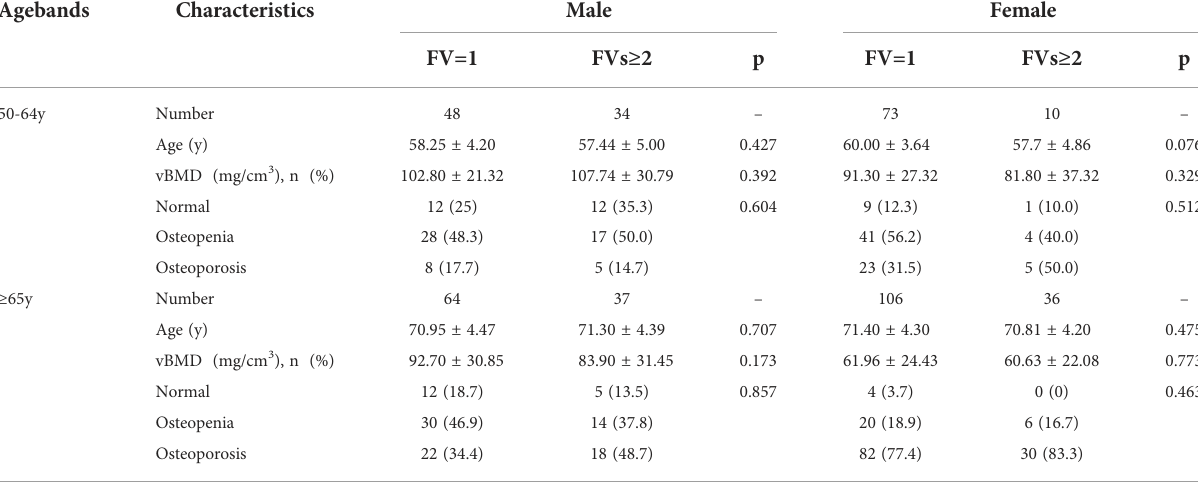
TABLE 4 Comparison of age and vBMD in the Grade 1 vertebral fracture (VF) group by number of fractured vertebra (FV) at different age bands ♦ . Agebands